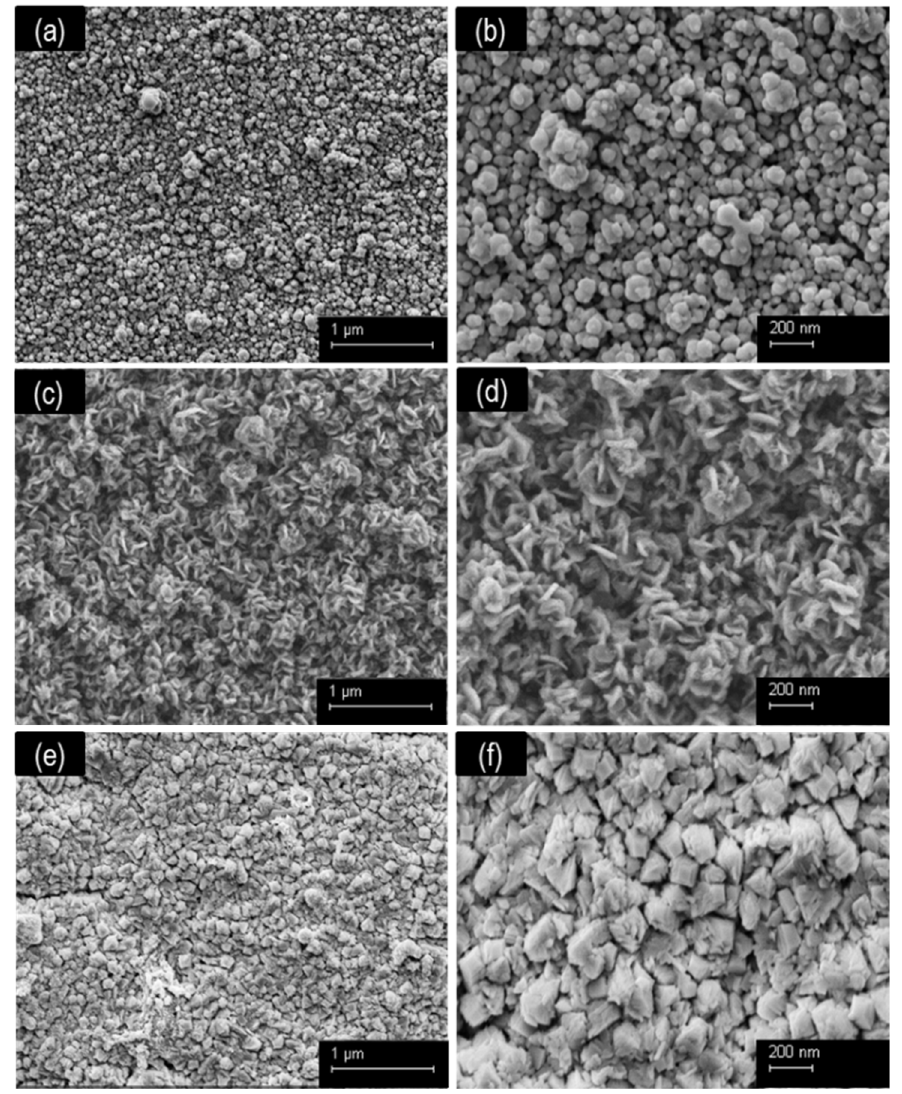
Figure 2. SEM micrographs of ( a , b ) Co 3 O 4 , MgCo 2 O 4 ( c , d ) and ( e , f ) MgO obtained by co-precipitation.